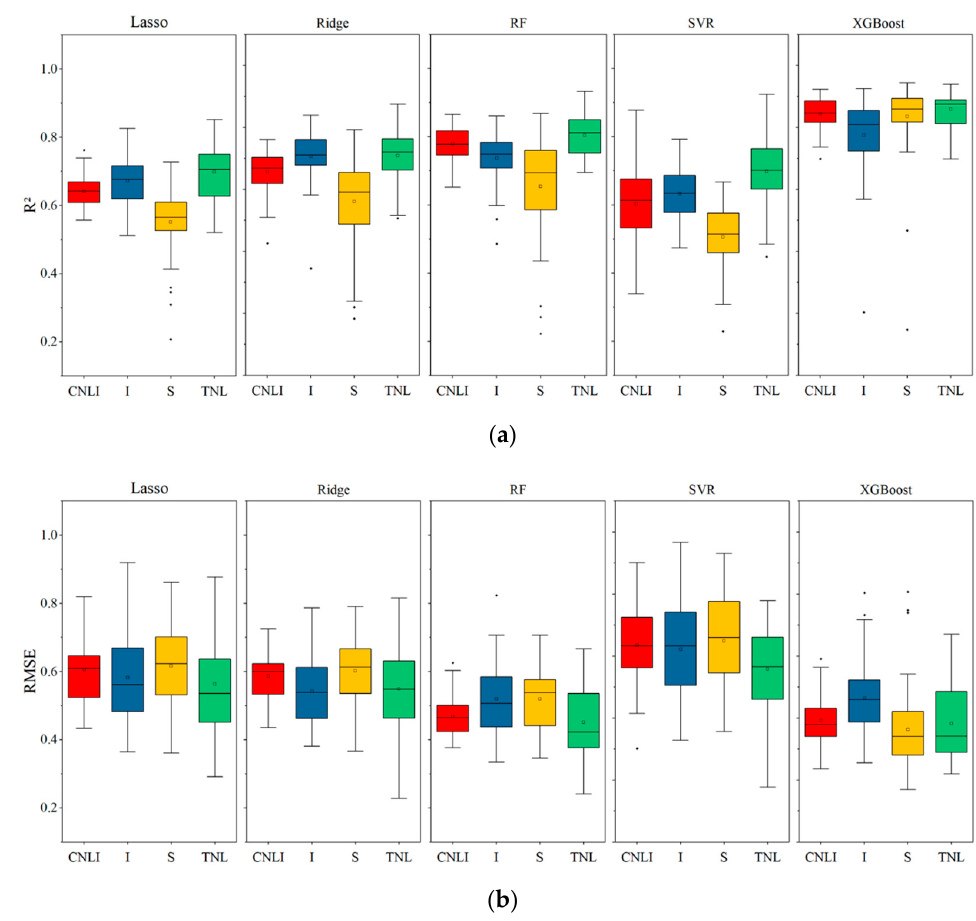
Figure 3. The performance testing of GDP forecasts using light indices and demographic variables for the period 2000–2020. The performance metrics for R 2 ( a ) and RMSE ( b ) were calculated for 50 random training-test samples.